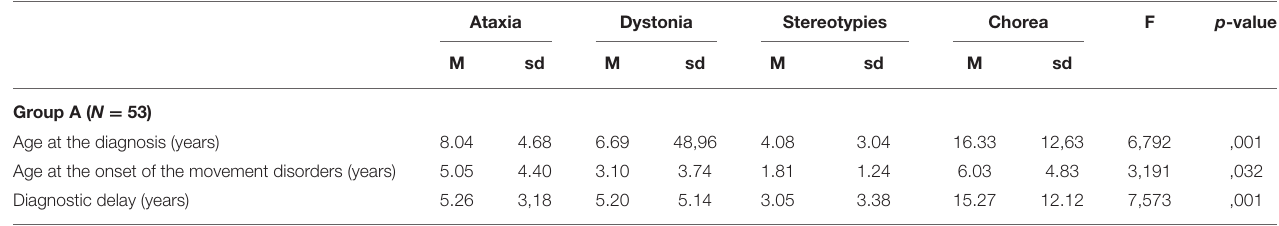
TABLE 6 | Differences in terms of age at diagnosis, age at the onset of movement disorders, and diagnostic delay according to the different hyperkinetic movement disorders that were observed in patients of Group A. Ataxia